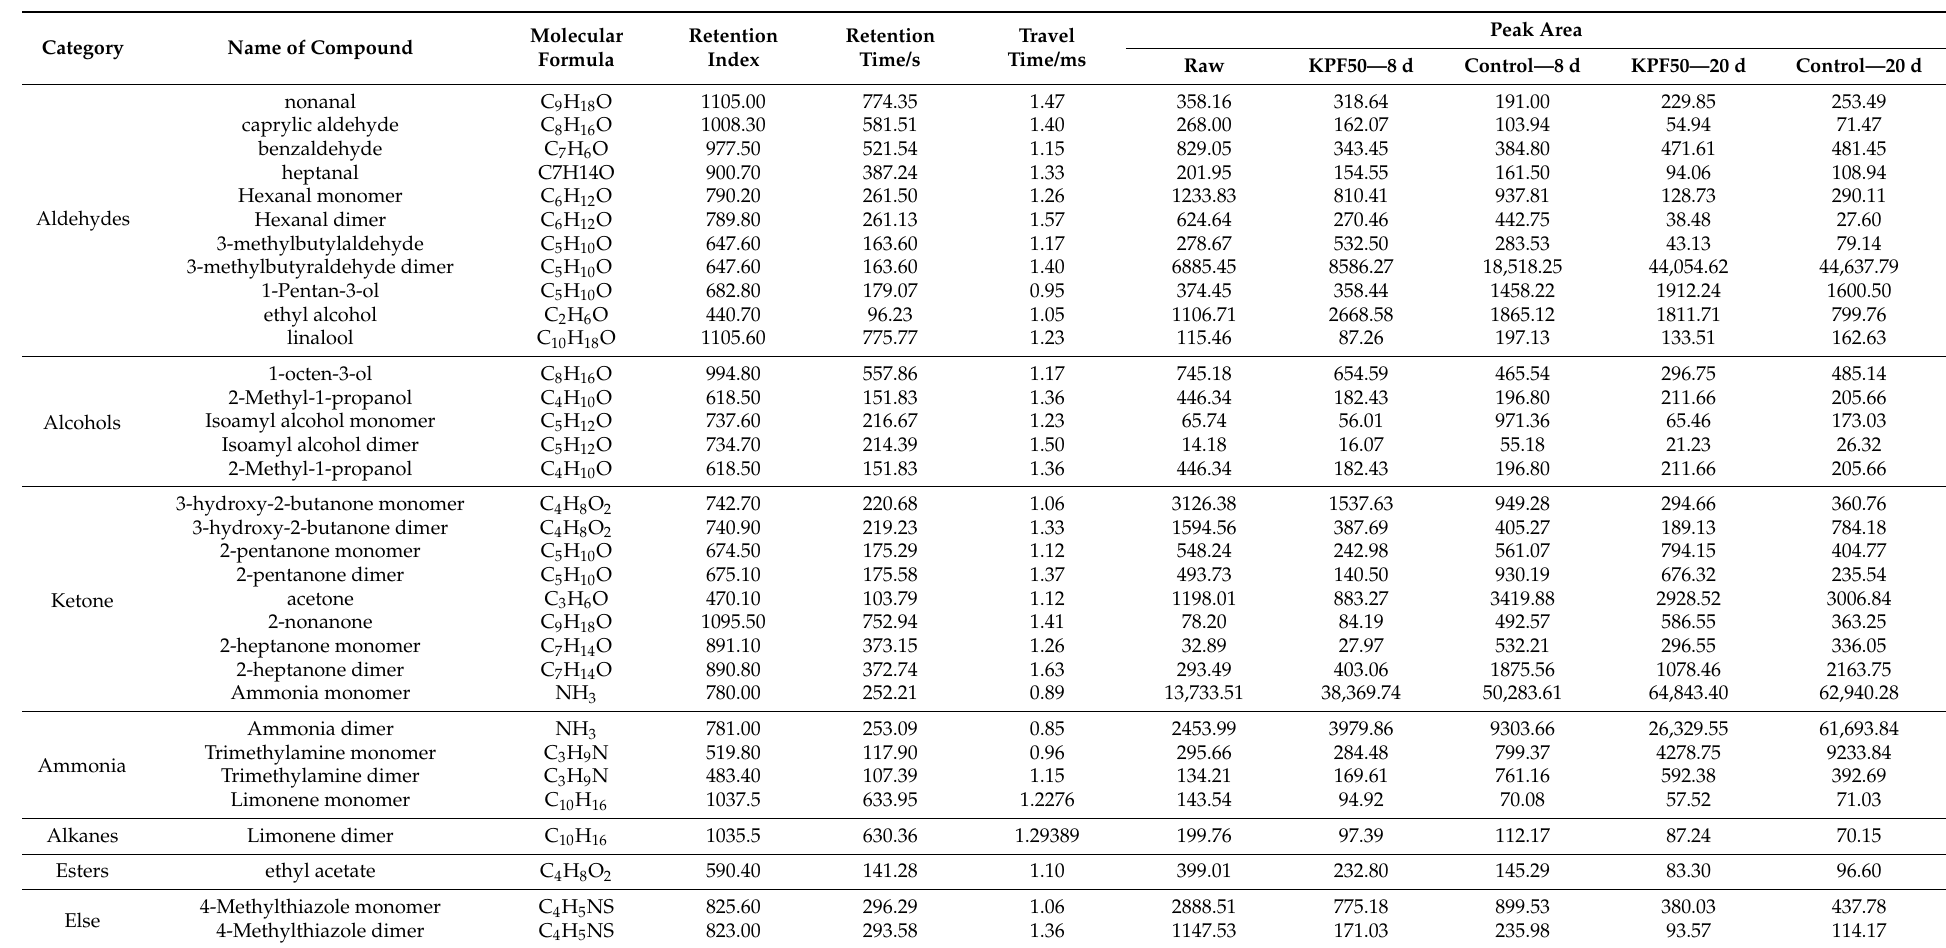
Table 3. Volatile ingredients of sea bass during different refrigeration storage